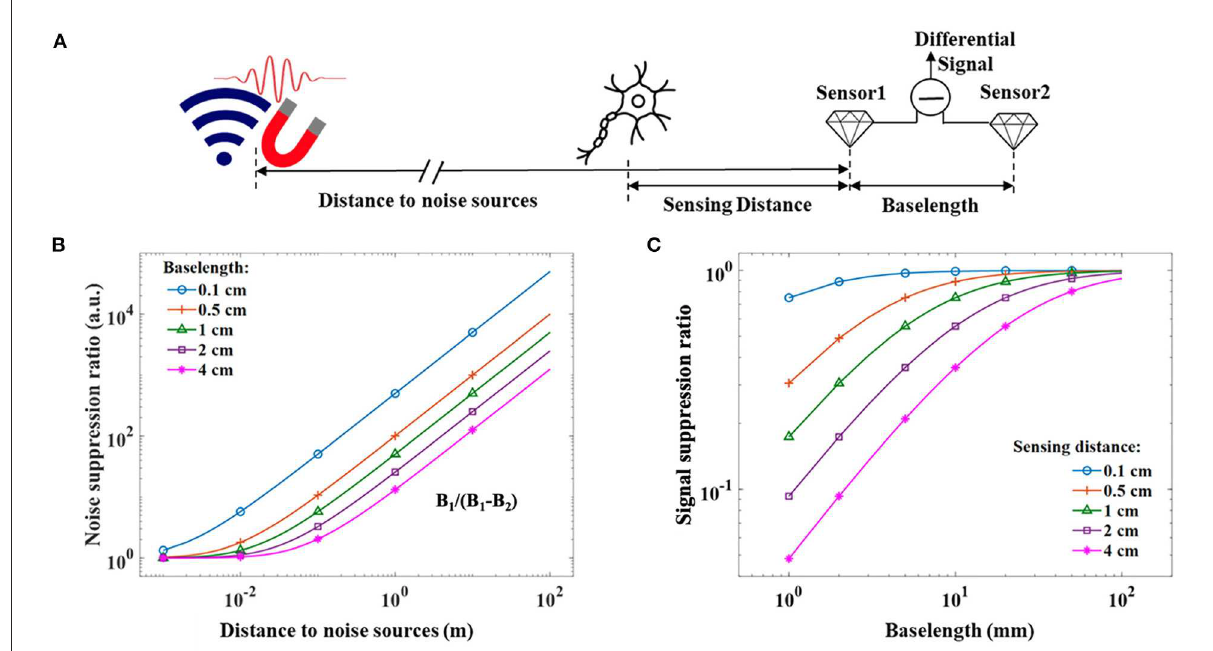
FIGURE6 (A) Sketch of relevant parameters that have to be taken into account when compromising the noise and signal suppression in a linear gradiometer configuration. (B) Noise suppression ratio for different baselengths as a function of the distance to the noise sources. (C) Relative differential signal of the gradiometers for different distances to the signal source as a function of baselength. For both cases, it is assumed that the magnetic field strength of the noise source and signal sources decay as B ( r )